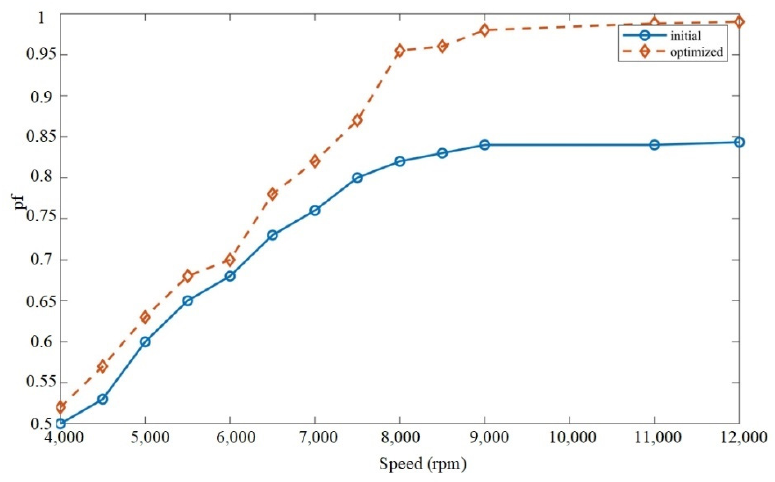
Figure 18. Power factor of initial and optimized design w.r.t different speed.